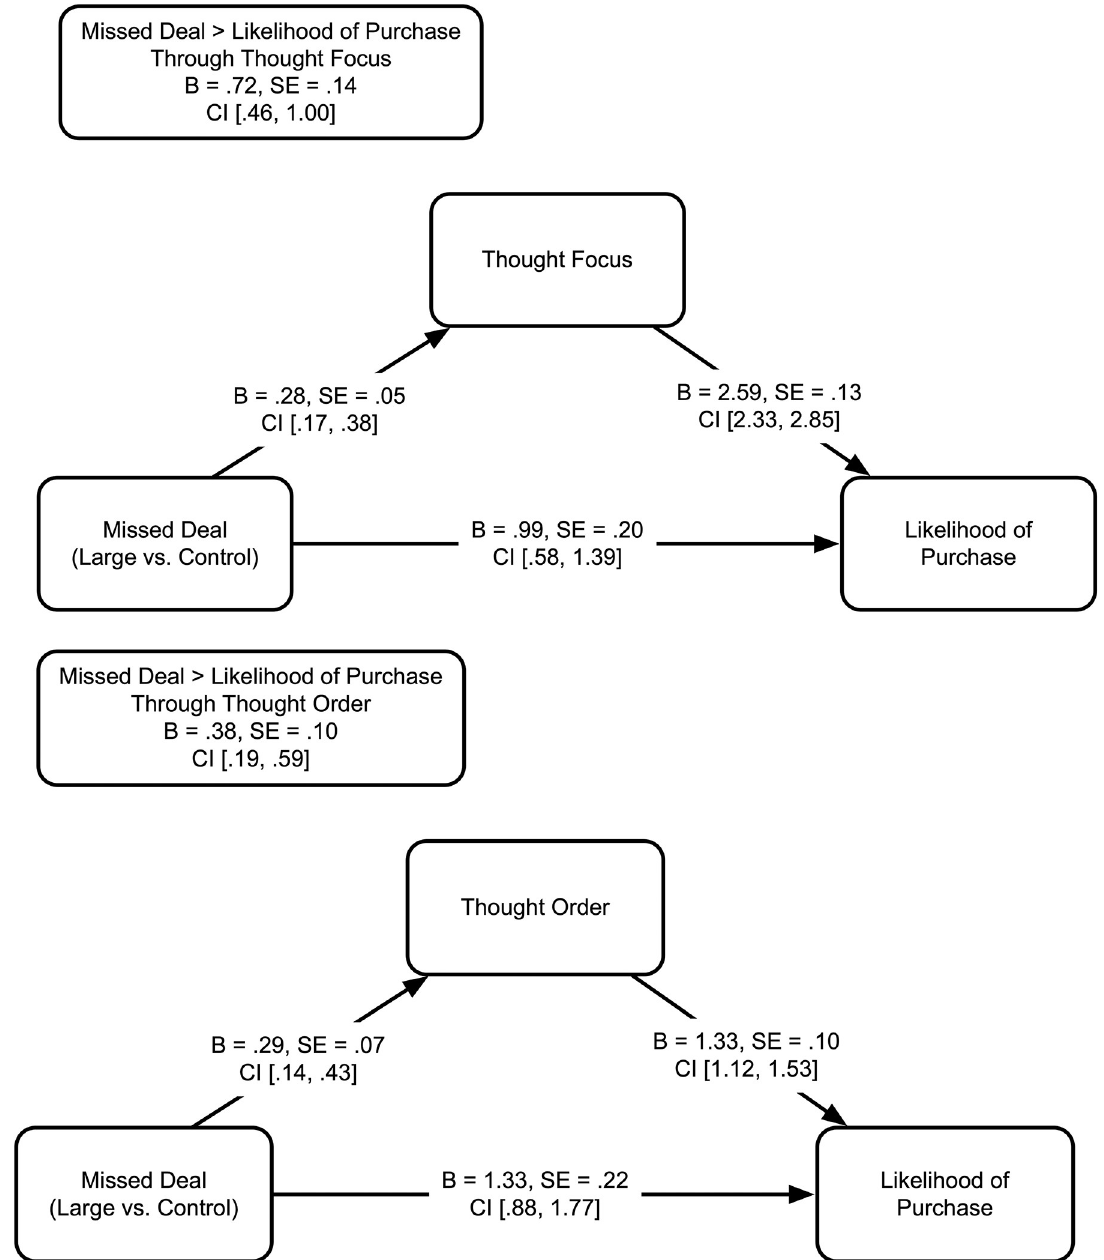
Fig 3. a. Indirect effect of missed deal on likelihood of purchase through thought focus . b. Indirect effect of missed deal on likelihood of purchase through thought order.